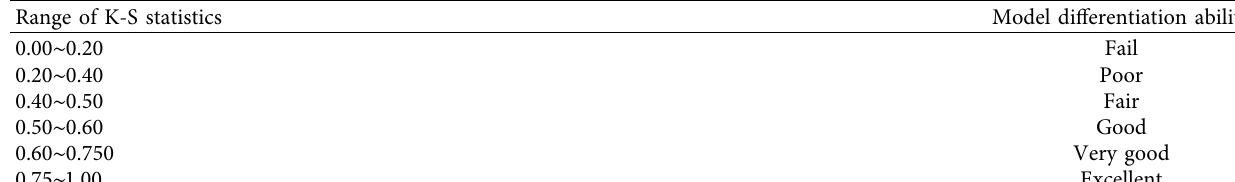
Table 5: K-S statistical range and its empirical assessment of model differentiation ability.